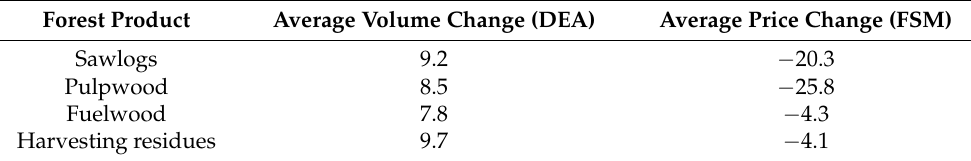
Table 1. Average volume and price changes due to more efficient harvesting operations Forest Product Average Volume Change (DEA) Average Price Change (FSM) Sawlogs 9.2 − 20.3 Pulpwood Fuelwood Harvesting residues −